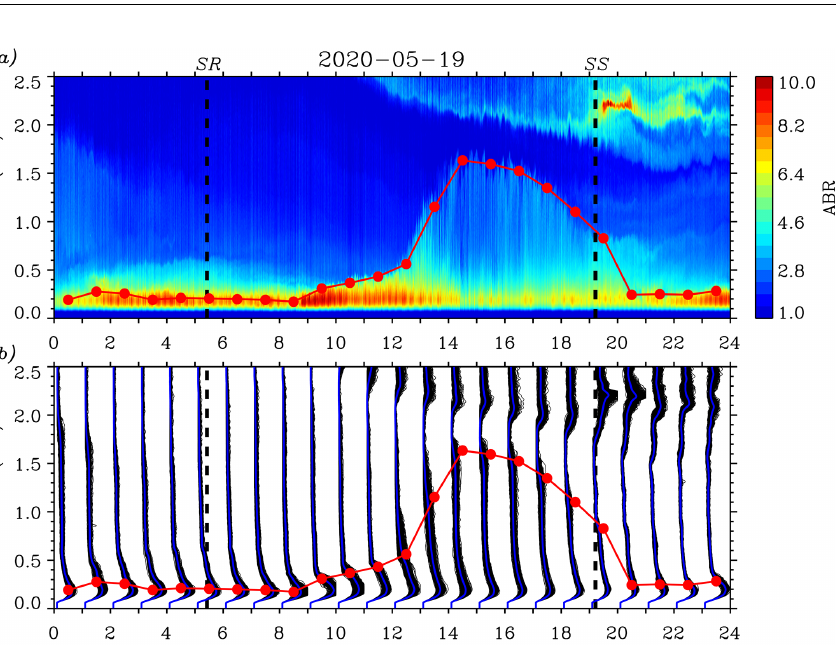
Figure 8a plots the instantaneous CBL depth (blue) ob- tained using the LGM method (before 09:00 and after 20:00 LT) and HWT method (between 09:00 and 20:00 LT). The hourly mean ABL depths (red solid circles) from vari- ance method are added. Figure 8b shows the hourly mean ABL depth growth rate (red solid circles). At the formation stage, the CBL depth growth rate changed sign from neg- ative to positive at ∼ 08:00 LT and reached a maximum of ∼ 0.14 km/h at around 09:00 LT. The EMT period is roughly defined between SR and 12:00 LT. The instantaneous CBL depths exhibited a small deviation from that indicated by the hourly mean ABL depth (red line) before 10:00 LT but showed increased deviation later on. At the growth stage, the CBL depth increased with a mean growth rate of > 0.48 km/h and a maximum growth rate of ∼ 0.59 km/h at